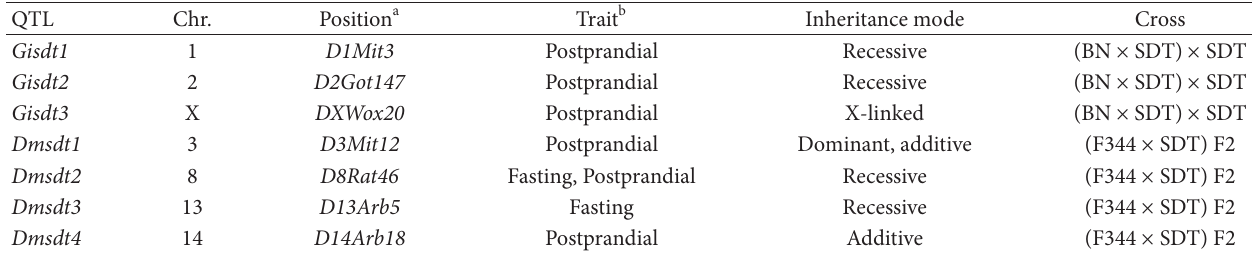
T 1: QTLs involved in glucose intolerance in SDT rats.